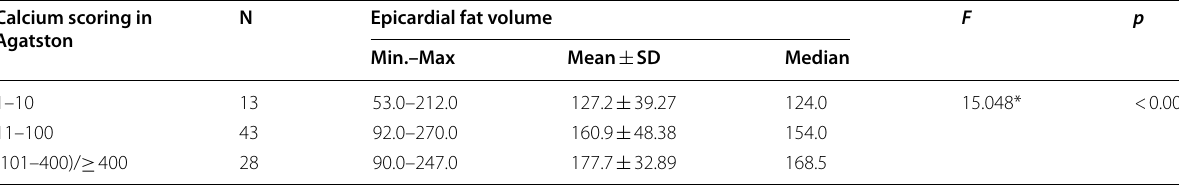
Table 3 Relation between epicardial fat volume and calcium scoring in Agatston ( n